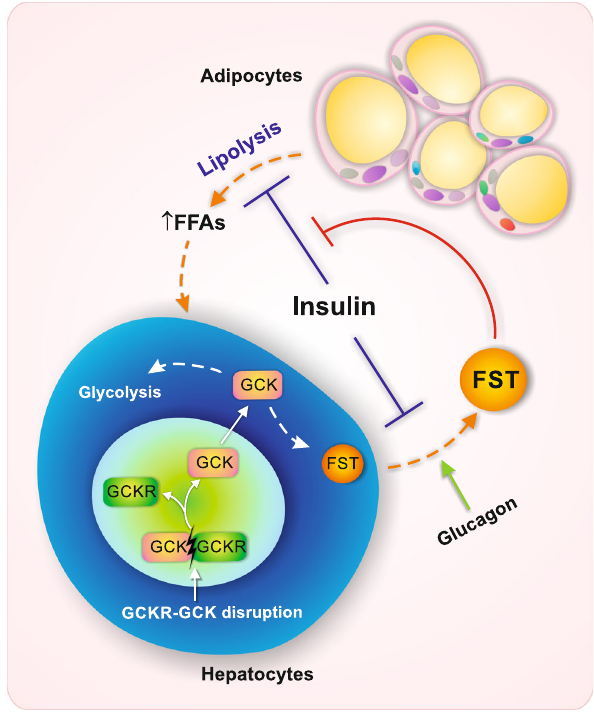
Fig. 5 Schematic illustration of crosstalk between liver follistatin production and adipocyte insulin-inhibited lipolysis. Liver follistatin (FST) secretion is regulated by GCKR-GCK, which is stimulated by glucagon and inhibited by insulin. Elevated follistatin may attenuate insulin-inhibited lipolysis in the adipocytes and mediate adipose tissue insulin resistance and free fatty acid (FFA) release, which ultimately contributes to T2D and NAFLD